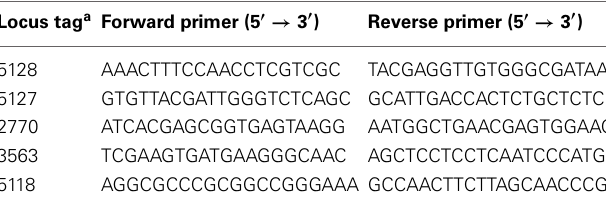
Table 1 | Primers used for the amplification of “unique” biotype 3